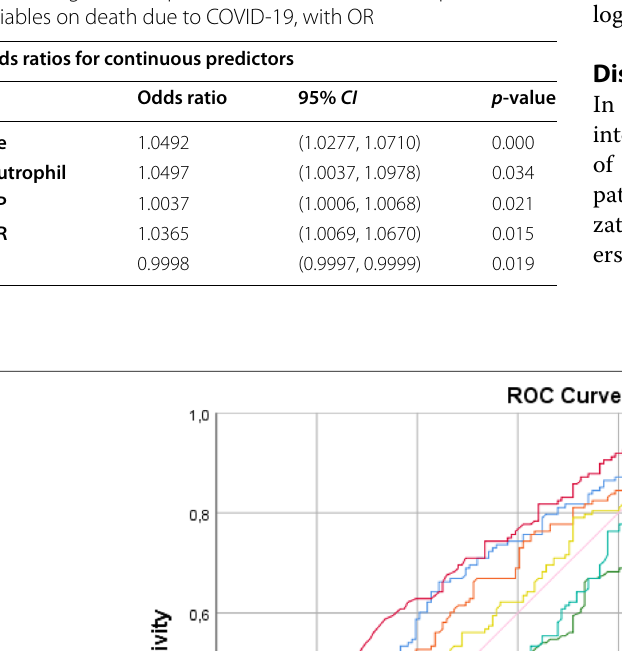
Mean standard deviation. *Significant p -value < 0.05. ICU , intensive care unit; PCT , Procalcitonin; CRP , C-reactive protein; NLR , neutrophil lymphocyte ratio; PLR , + ± platelet lymphocyte ratio, SII , systemic inflamatory index. [Platelet